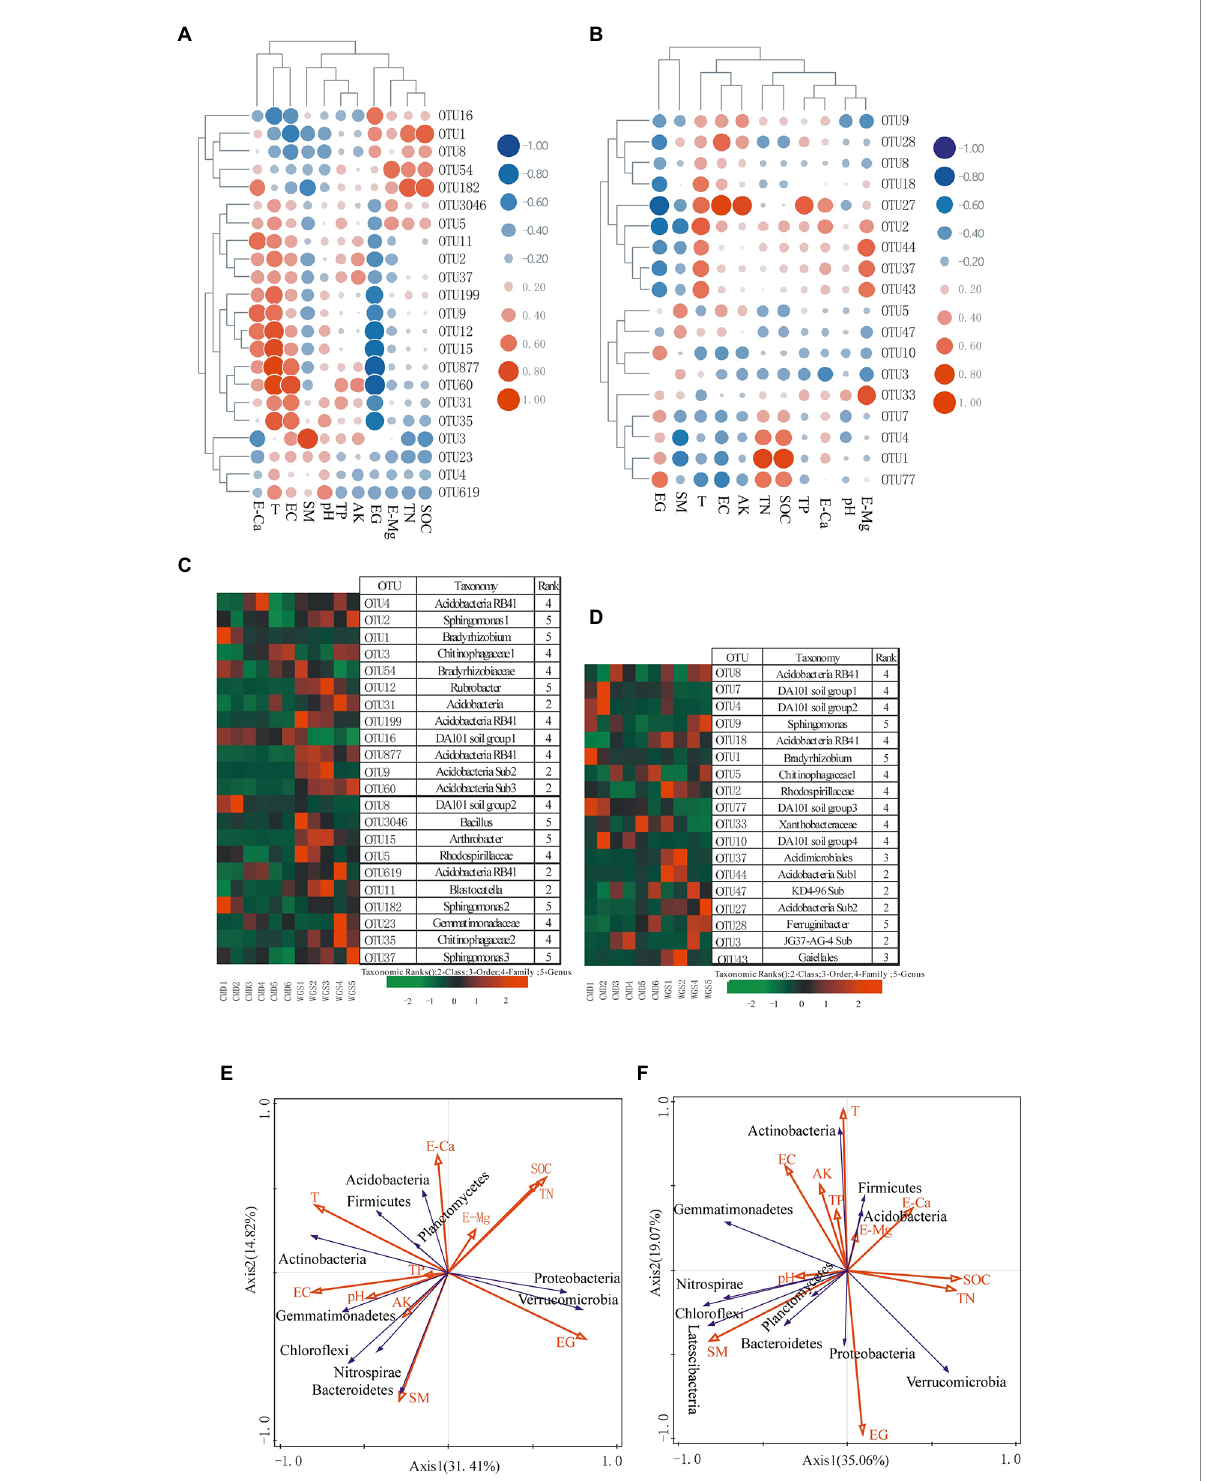
FIGURE 6 Heat map representing relationships between the most abundant OTUs (>0.5%) and environmental factors (A) from A layer and (B) from B layer, as well as the relative frequency of the most abundant OTUs (>0.5%) in each sampling site (C) from A layer and (D) from B layer. RDA plots displaying the relationships between environmental factors and the identified phyla (E) from A layer and (F) from B layer. EG indicating altitudinal